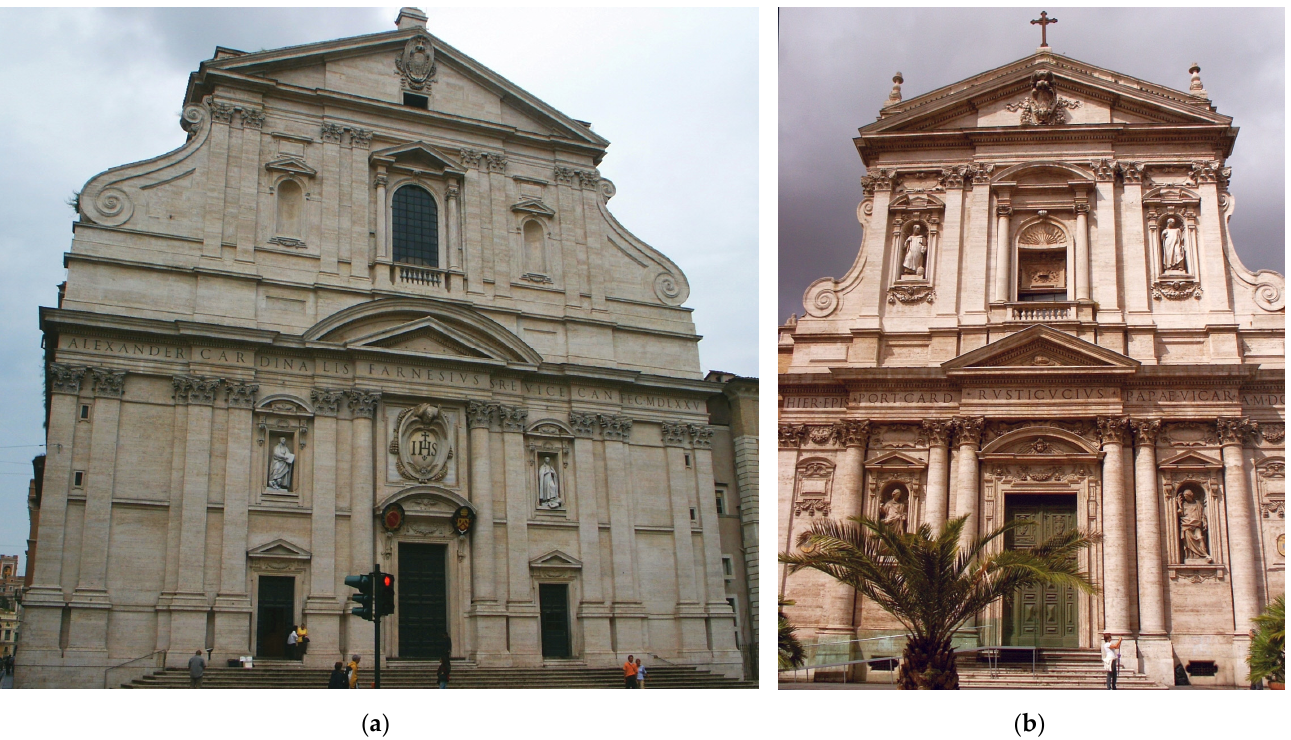
Figure 1. Monochromatic façades made of travertine: ( a ) the façade of the Jesuit church Il Gesù (Giacomo Della Porta, 1584); ( b ) the façade of the church of S. Susanna in Rome (1597–1603). Photos from private collection.